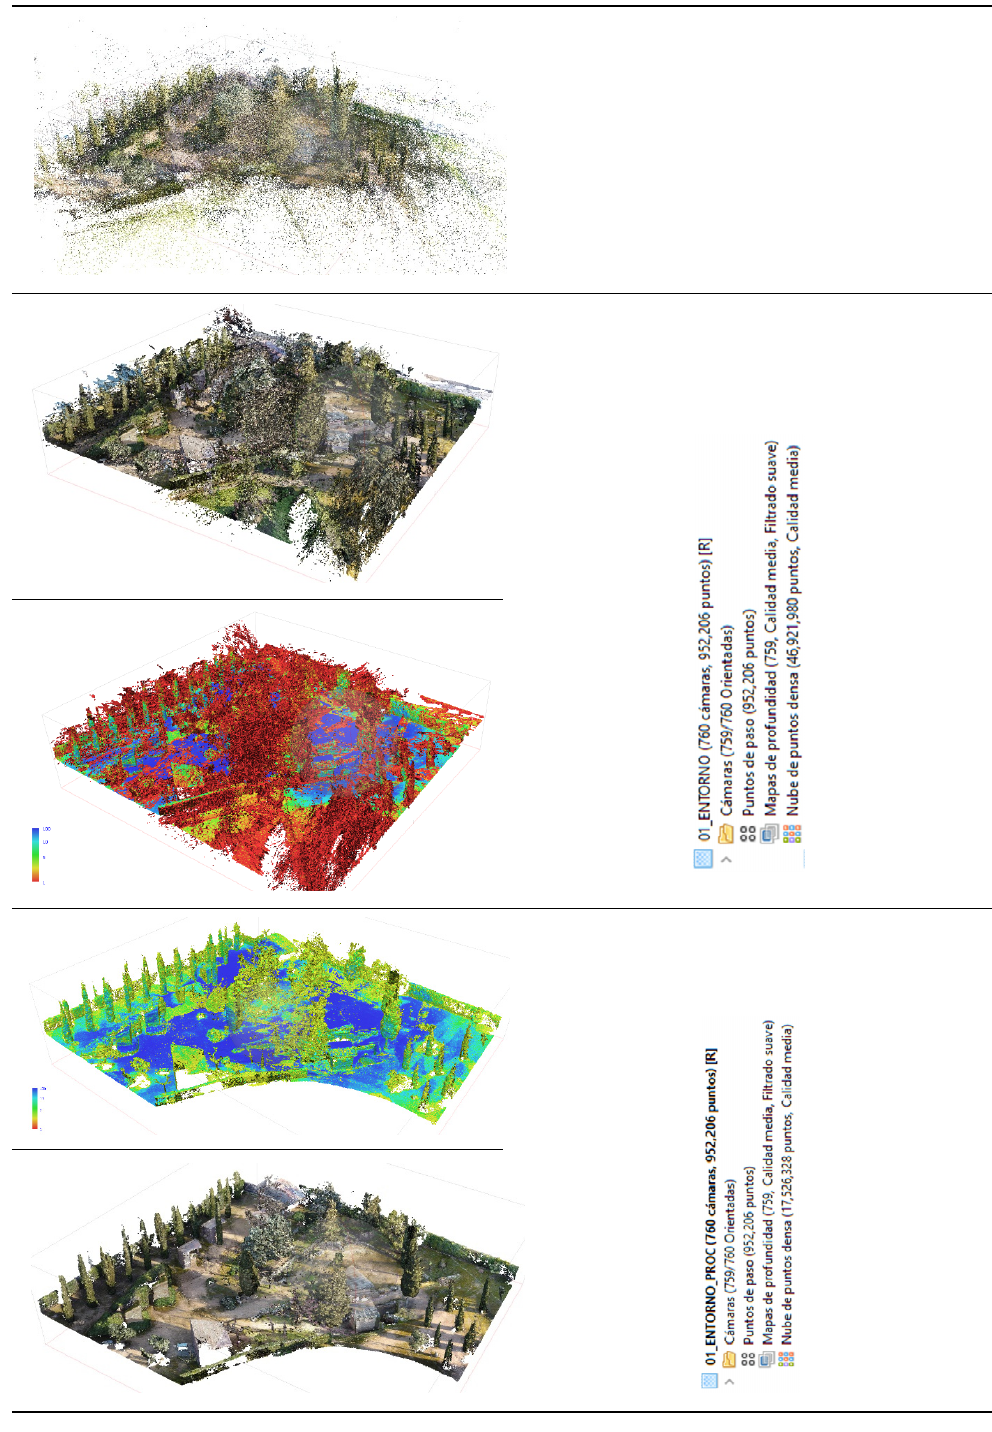
Table 6. Point cloud generation process in Photoscan of the topography of the environment.